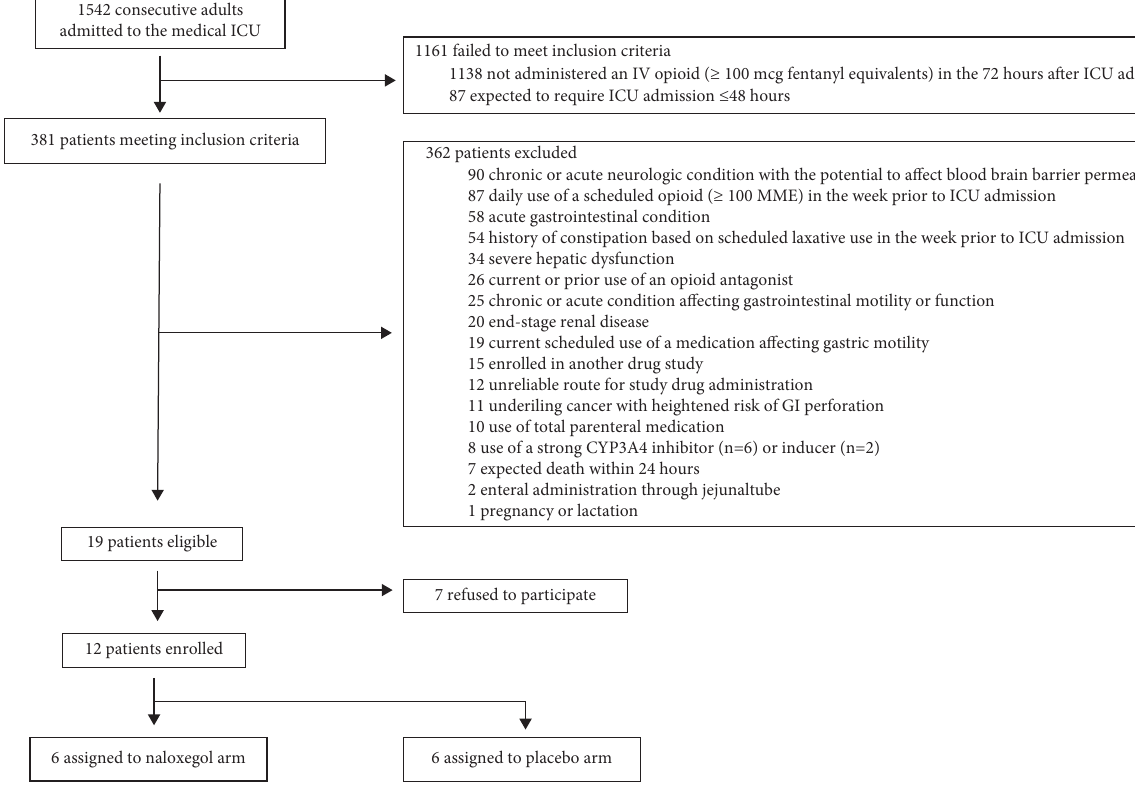
Figure 1: Patient screening, recruitment, and randomization. The number of patients excluded for each criterion sum is more than the total because some patients met more than one exclusion criteria.